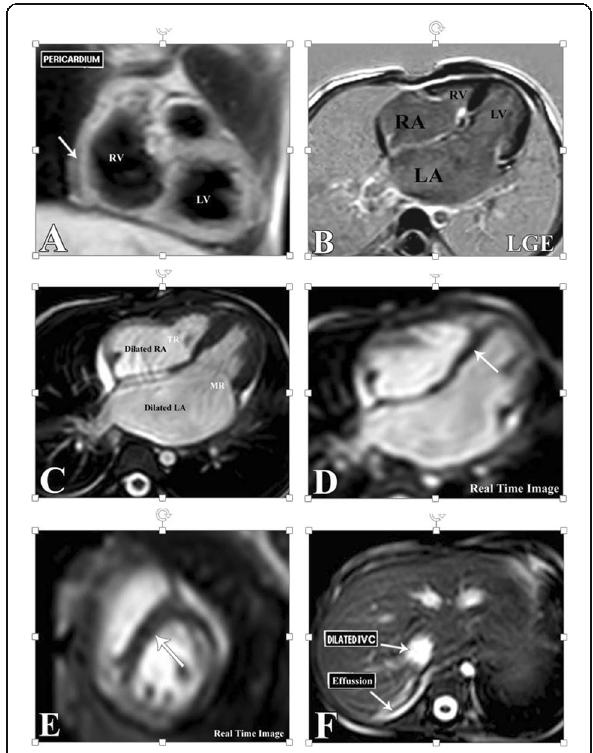
Fig. 7 Idiopathic restrictive cardiomyopathy. Two-year-old female presented with signs of right-sided HF and systemic congestion. Cine SSFP 4 chamber views ( a ) show average-sized both LV and RV with normal thickness of LV myocardium and massive enlargement of both atria with TR, MR seen in a and normal EF of both ventricle. Short axis Black Blood T1 ( b ) show normal pericardial thickness without enhancement (in f ). Normal movement of septum with respiration (arrow) in real-time images short axis ( c ) and 4-chamber view ( d ). Dilated IVC with mild right pleural effusion (arrows) seen in image ( e ). No abnormal signal or abnormal delayed enhancement in short axis and 4-chamber LGE views ( f ) to suggest